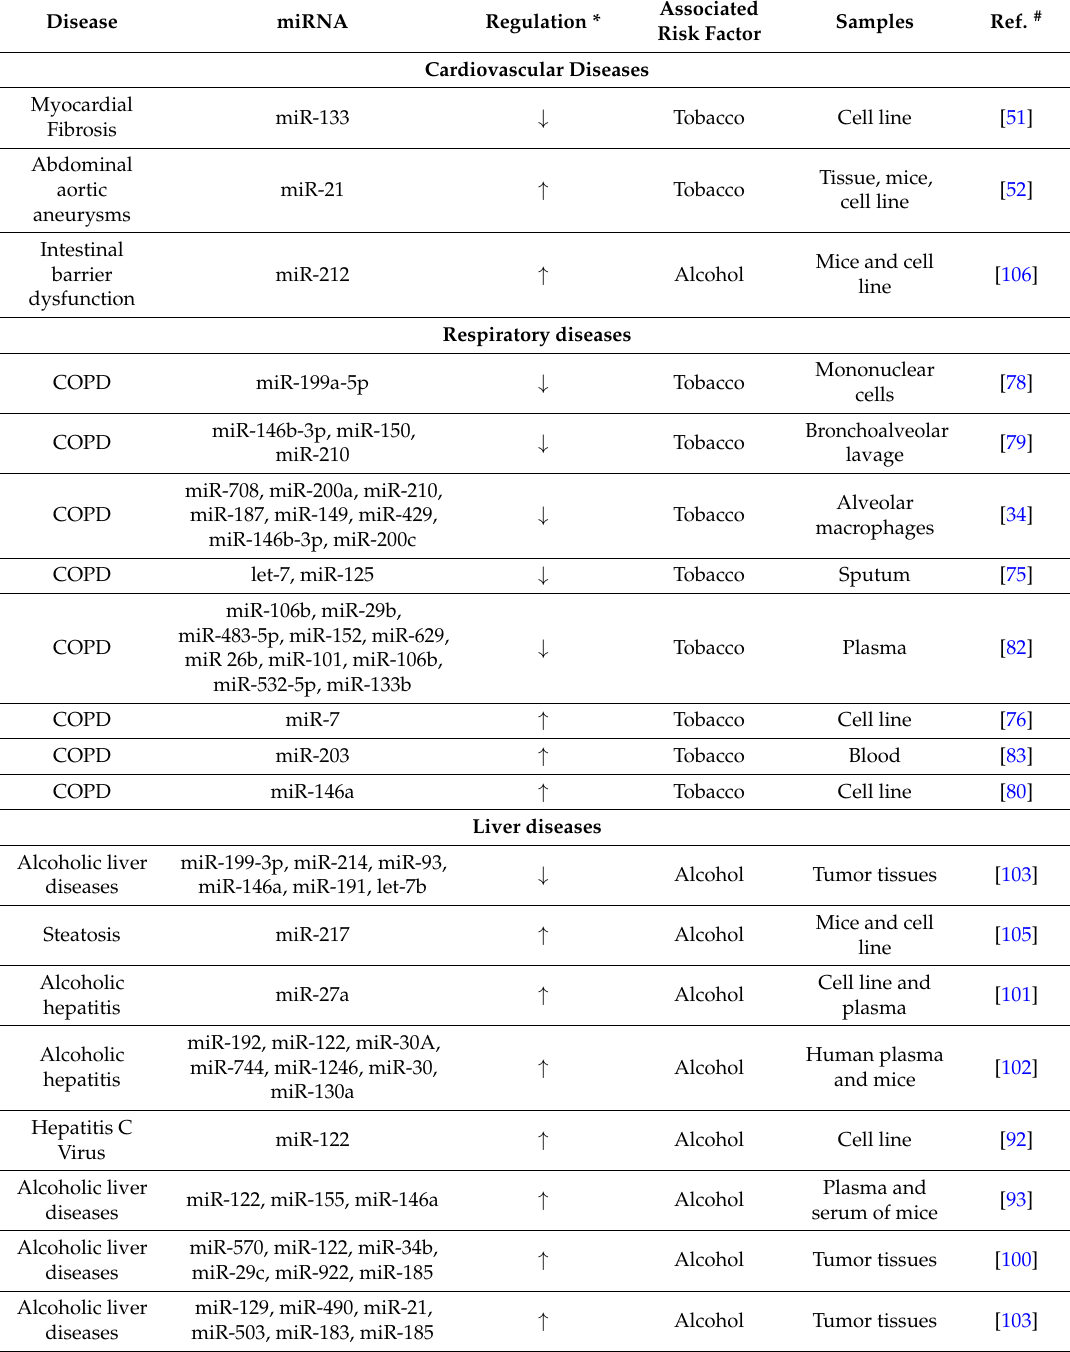
Legends: * Regulation: Green arrows indicate miRNA downregulation; Red arrows indicate miRNA upregulation; COPD: Chronic obstructive pulmonary disease; Ref. # : References; All miRNAs reported in this table have been altered by exposure to alcohol or